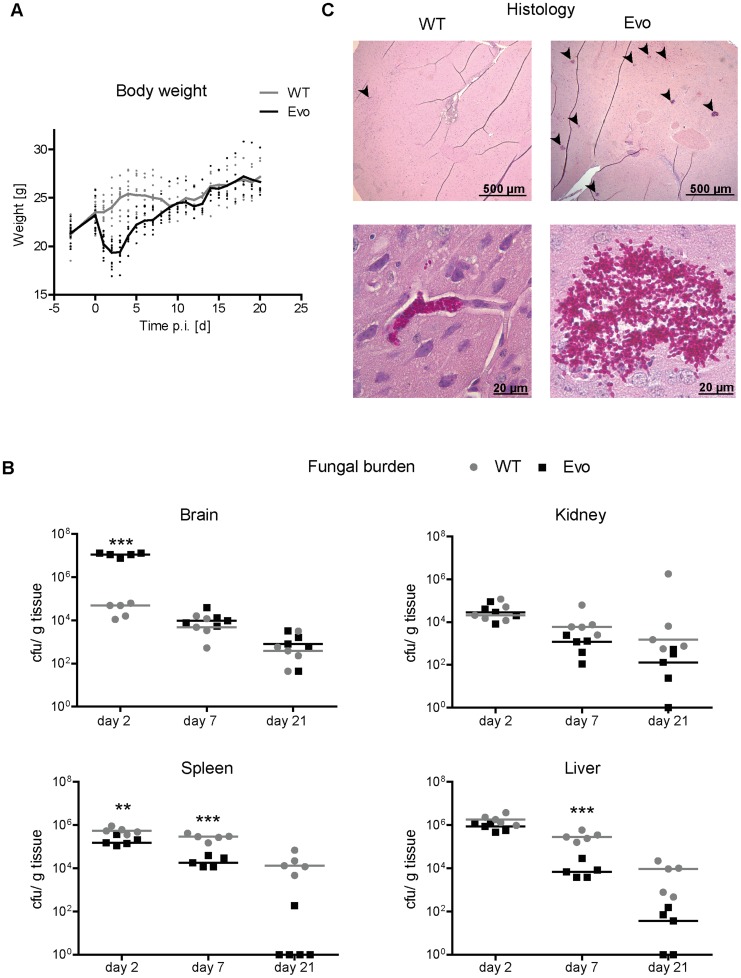
Enhanced virulence and altered organ tropism of the evolved strain.A. Mice were intravenously infected with 5×107
C. glabrata cells on day 0. Body weight of animals was monitored daily. During the first four days, infection with the evolved strain (Evo) led to severe loss in body weight, in contrast to mice infected with the parental strain (WT). B. Fungal burden was determined by culture from tissue homogenates of five animals per treatment group and time point. The distribution of fungal burden differed significantly between the wild type (WT) and the evolved strain (Evo) at the early time point. In the brain, the burden on day 2 p.i. was more than 100× higher for the evolved strain than for the wild type (median 1.1×107 cfu/ml vs. 4.9×104 cfu/ml). This difference was not present at later time points (days 7 and 21 p.i.), and both strains persisted at comparable levels in the organ. C. Representative histological images of brain tissue of infected mice. Brains infected with the evolved strain (Evo) showed large and numerous microcolonies (upper right picture, microcolonies are indicated by black arrows). Evo cells formed larger clumps of cells; the wild type (WT) formed only few small microcolonies in the brain (upper and lower left picture, a microcolony is indicated by a black arrow). Please note that the PAS stain used does not allow reliable differentiation between neuronal and endothelial cells.